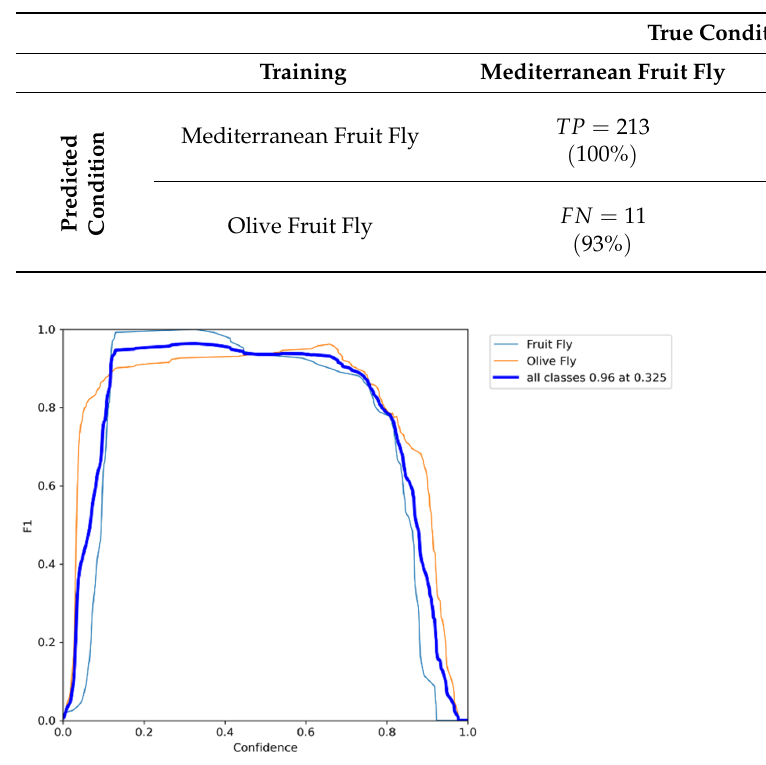
Figure 5. YOLO training F1 score results.